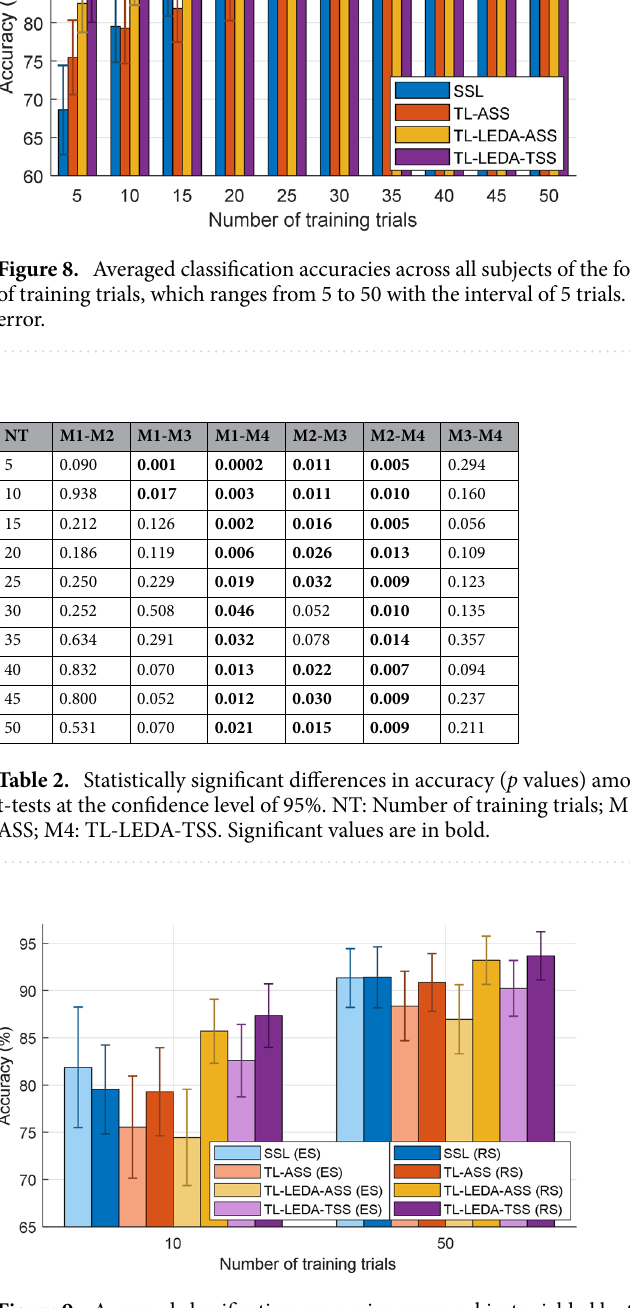
Figure 9. Averaged classification accuracies across subjects yielded by the two groups of algorithms derived from Euclidean and Riemannian space respectively in the cases of 10 and 50 training trials. ES and RS denote Euclidean space and Riemannian space respectively. The error bars represent the standard